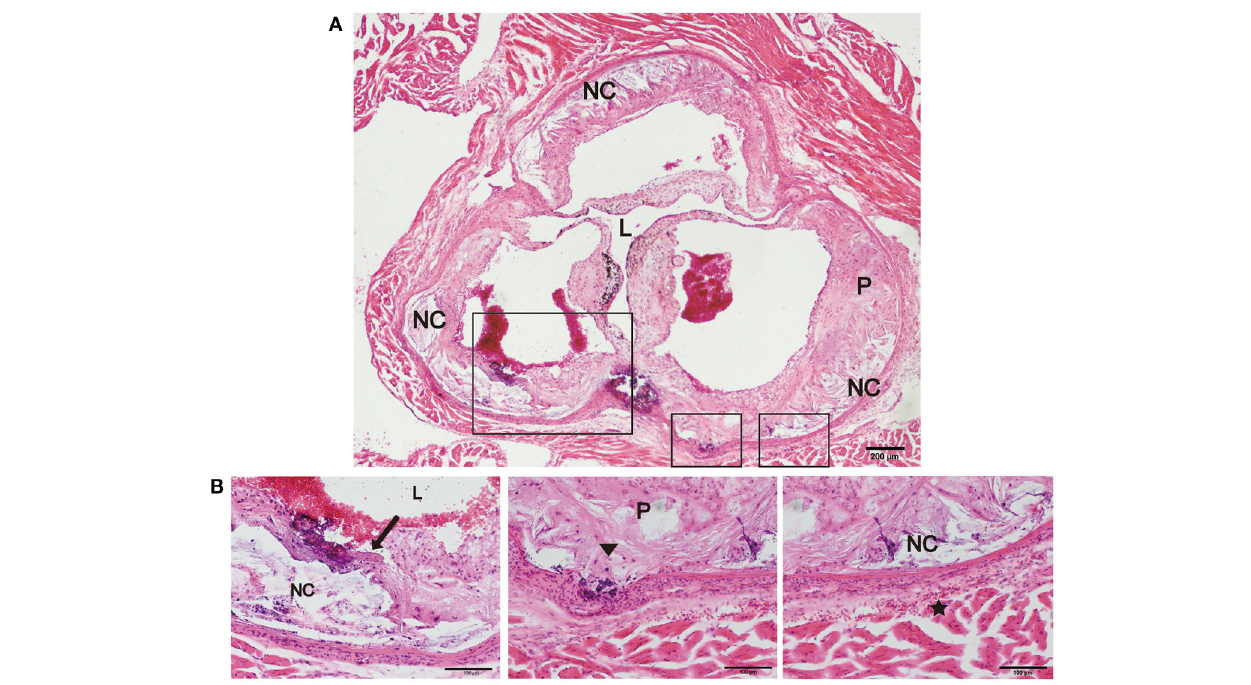
FIGURE 5 | Plaque rupture and vasa vasorum generation in Fbn1 C1039G + / − LDLR − / − mice. (A) Plaque rupture and secondary thrombosis in Fbn1 C1039G + / − LDLR − / − mice after HFD feeding. (B) Partial enlargements of (A) . The arrow shows the ruptured fibrous cap, the triangle shows the fragmentation of elastin, and the star shows the vasa vasorum network. P, plaque; L, lumen; NC, necrotic